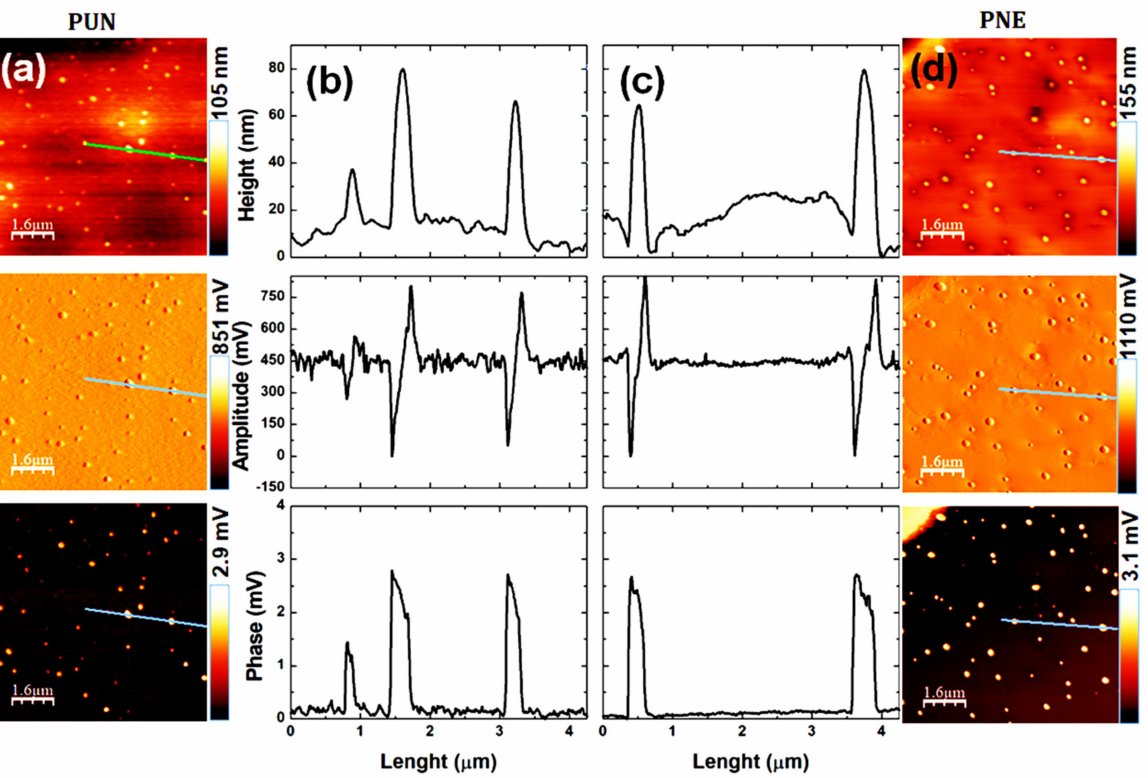
Figure 5. AFM images evaluation based on ( a ) topography, ( b ) amplitude (error signal), ( c ) phase images and ( d ) graphic profiles of the highlighted line of the biodefensives PUN and